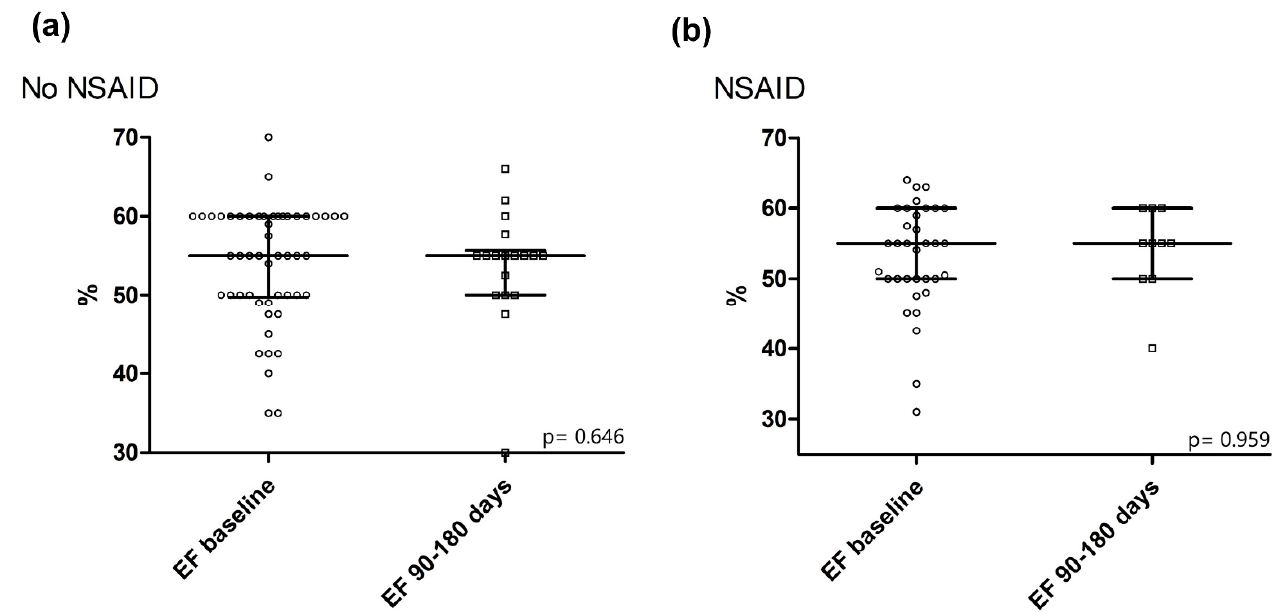
Figure 2. Left ventricular systolic function at baseline and at follow-up 90 to 180 days after hospital- ization in ( a ) patients who did not receive NSAIDs and ( b ) patients treated with NSAIDs. Depicted is the p -value for the Wilcoxon signed-rank test for paired samples. Abbreviations: EF = ejection fraction, NSAID = non-steroidal anti-inflammatory